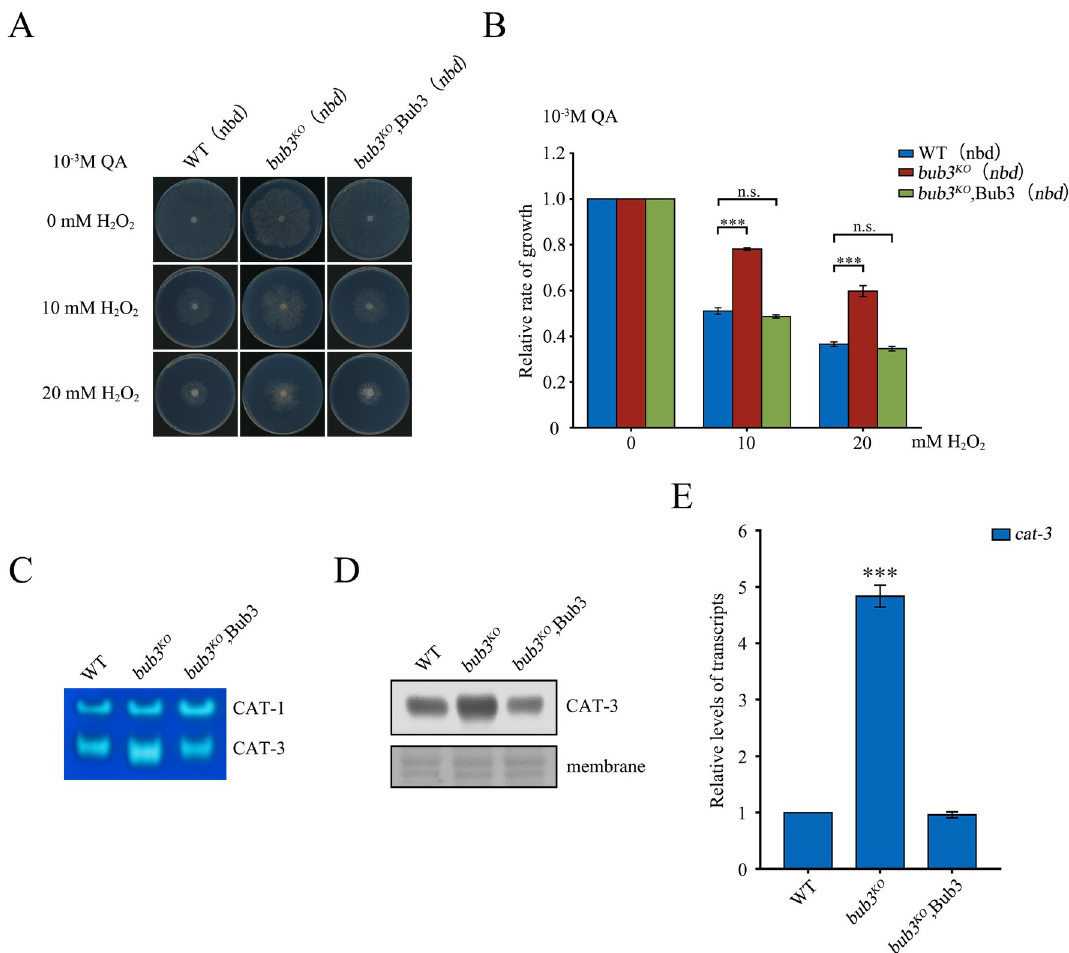
Fig 1. Bub3 functions to suppress cat-3 gene expression. (A) Mycelial growth of WT, bub3 KO , and bub3 KO ,Bub3 ( nbd ) strains on plates with addition of 1x10 -3 M QA and 0, 10, or 20 mM H 2 O 2 . (B) Quantitation of growth relative to WT of bub3 KO and bub3 KO , Bub3 ( nbd ) strains under conditions described in panel A. (C) In-gel catalase activity assay of protein extracts from WT, bub3 KO , and bub3 KO ,Bub3 strains. (D) The level of CAT-3 protein in WT, bub3 KO , and bub3 KO ,Bub3 strains determined by western blot analyses. The membranes stained by Coomassie blue served as the loading control. (E) Levels of cat-3 mRNA in bub3 KO and bub3 KO ,Bub3 strains relative to that in the WT strain as determined by RT-qPCR analyses.Cultures were inoculated at the center of petri dishes (9 cm in diameter) and grown at 25˚C under constant light. Error bars indicate SD (n = 3). Significance was evaluated by two-tailed t - test. � P < 0.05, �� P < 0.01, and ��� P <